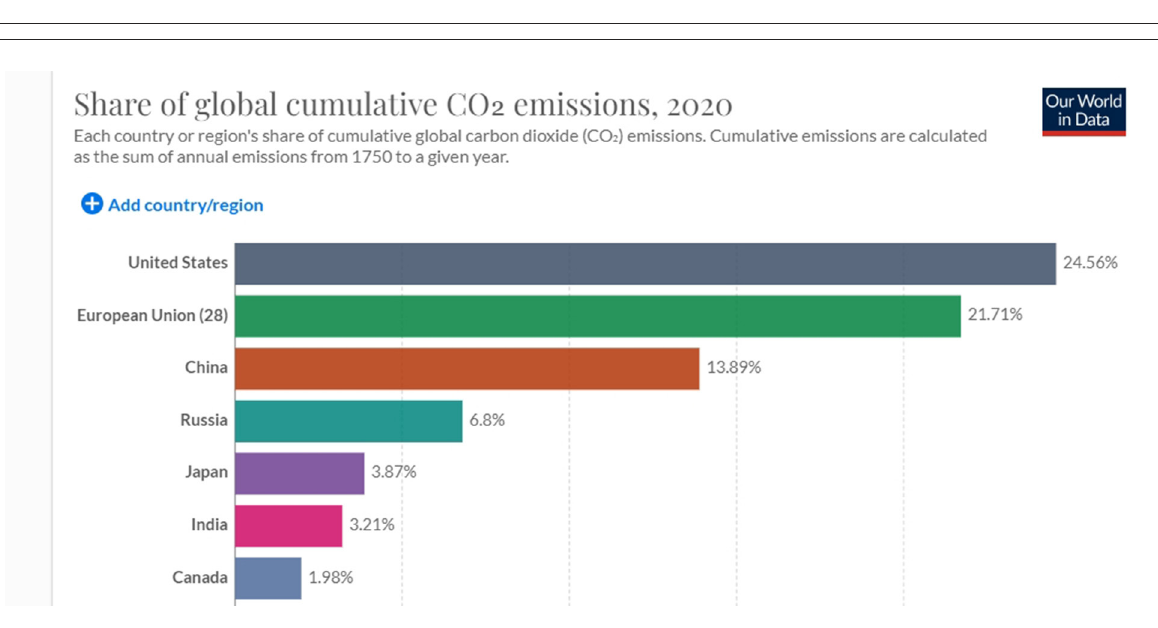
ethical communities”: “human communities with a track